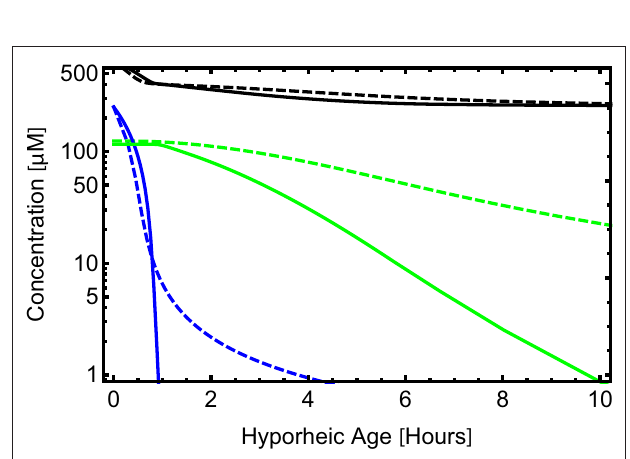
FIGURE 7 | Hyporheic zone concentration for the ADELS model (solid curves) and the mTSM (dashed curves). The blue curve represents oxygen concentration, the green curve nitrate, and the black curve DOC. The x -axis is hyporheic age in the ADELS model and a characteristic time related to the exchange coefficient in the